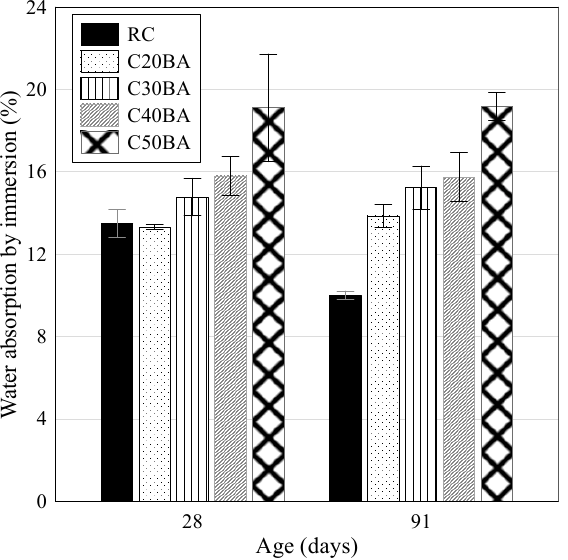
Figure 8. Water absorption by immersion at 28 and 91 days.